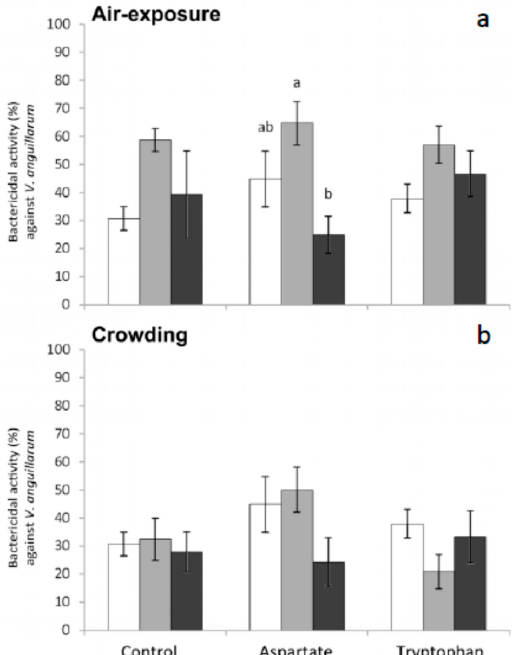
Figure 5. Bactericidal activity (%) against V. anguillarum in fish stressed by ( a ) air-exposure or ( b ) crowding. Results are shown as mean ± standard error. Different letters indicate significant differences among non-stressed fish (white bars), 1 h post stress (grey bars) and 6 h post stress (black bars). Differences were considered significant when p < 0.05.